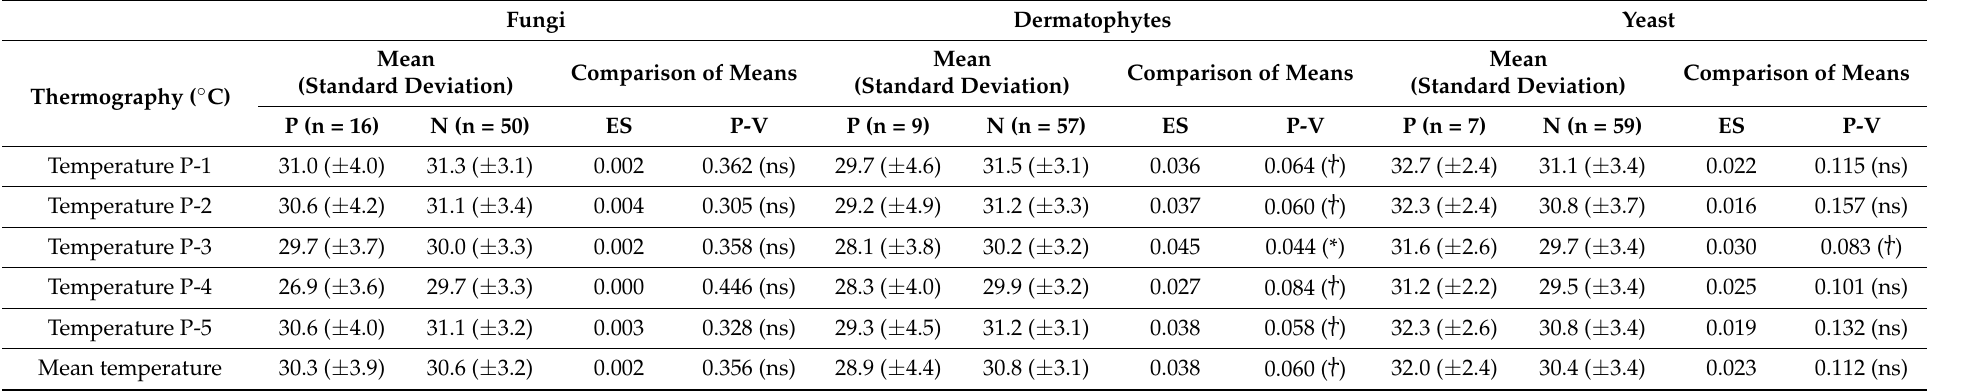
Table 5. Relation between results of thermography variables and prevalence of infection in men: fungi, dermatophytes and yeast. Fungi